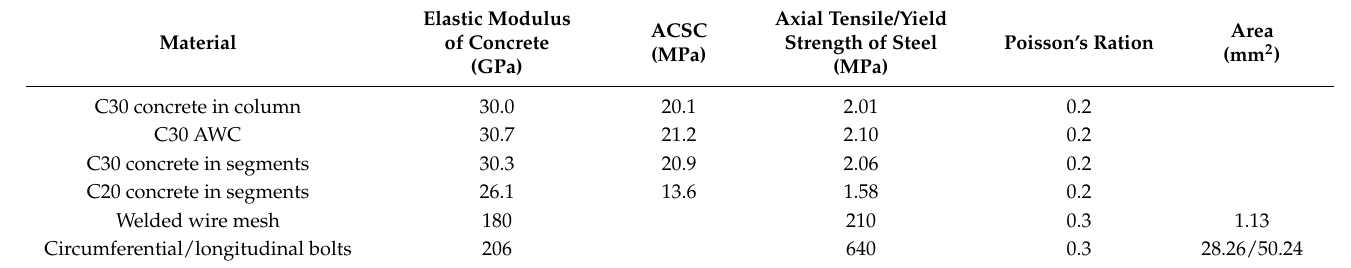
Table 5. Performance of the